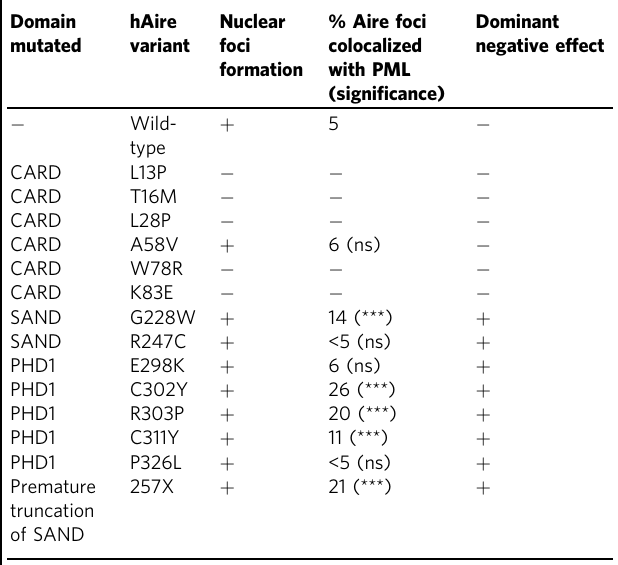
Table 1 Nuclear localization and dominant negative effects of hAire APS-1